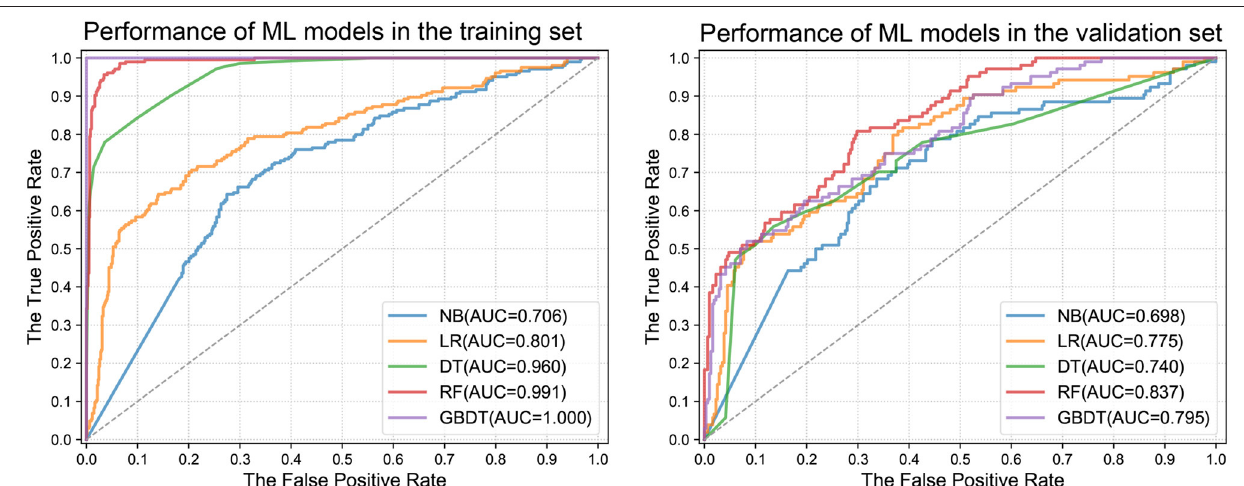
Frontiers in Cardiovascular Medicine | www.frontiersin.org